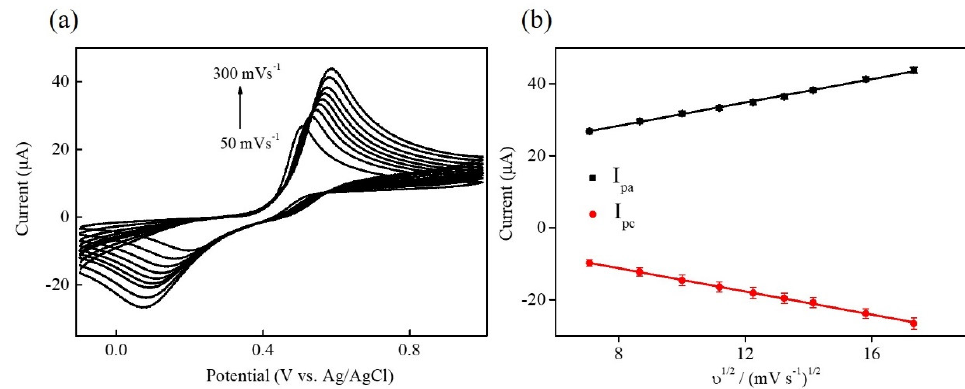
Figure 6. ( a ) CV curves of Ni–Co–Te/Nafion-modified GCE in 0.1 M PBS (pH = 7.0) in the presence of 1 mM acetaminophen at different scan rates from 50 (line a) to 300 (line i) mV s − 1 . ( b ) The plot of the square root of the scan rate ( υ 1/2 ) vs. the anodic and cathodic peak current (I pa and I pc ).